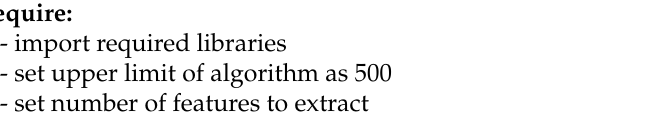
Algorithm 1 Pseudocode of the proposed